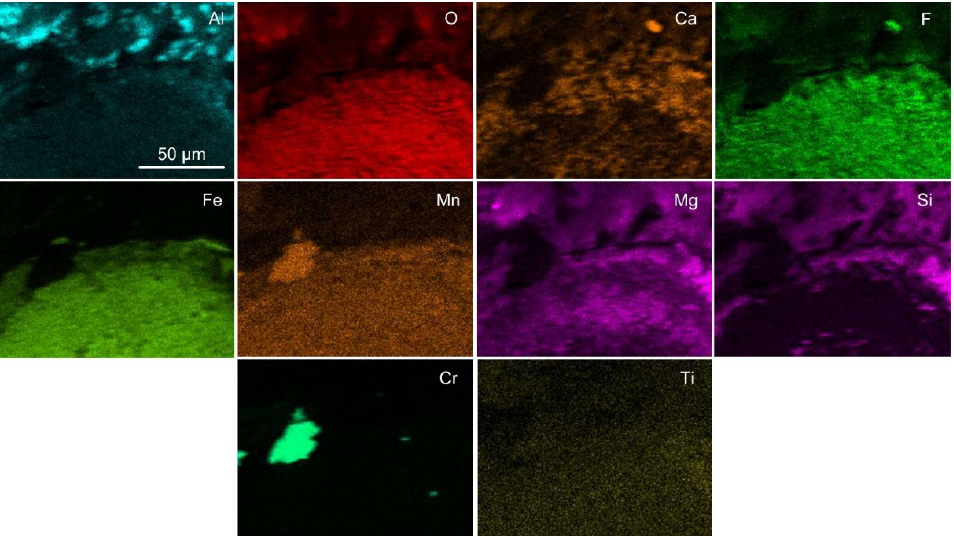
Figure 4. EDX map of marked area in Figure 2c: MP2 slag sample.